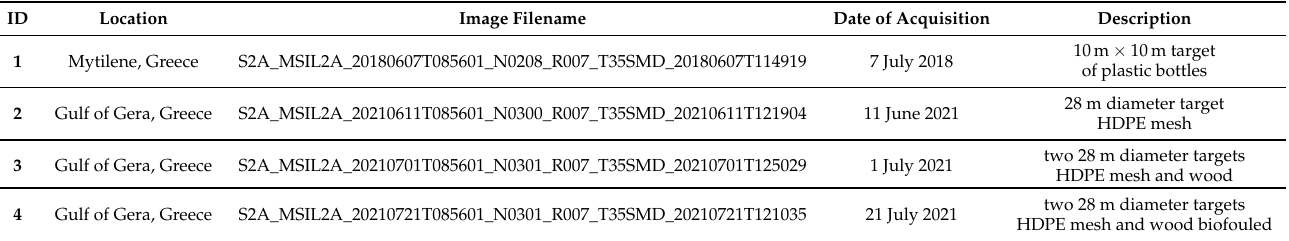
Table 3. Table describing the images collected from S2 containing plastic